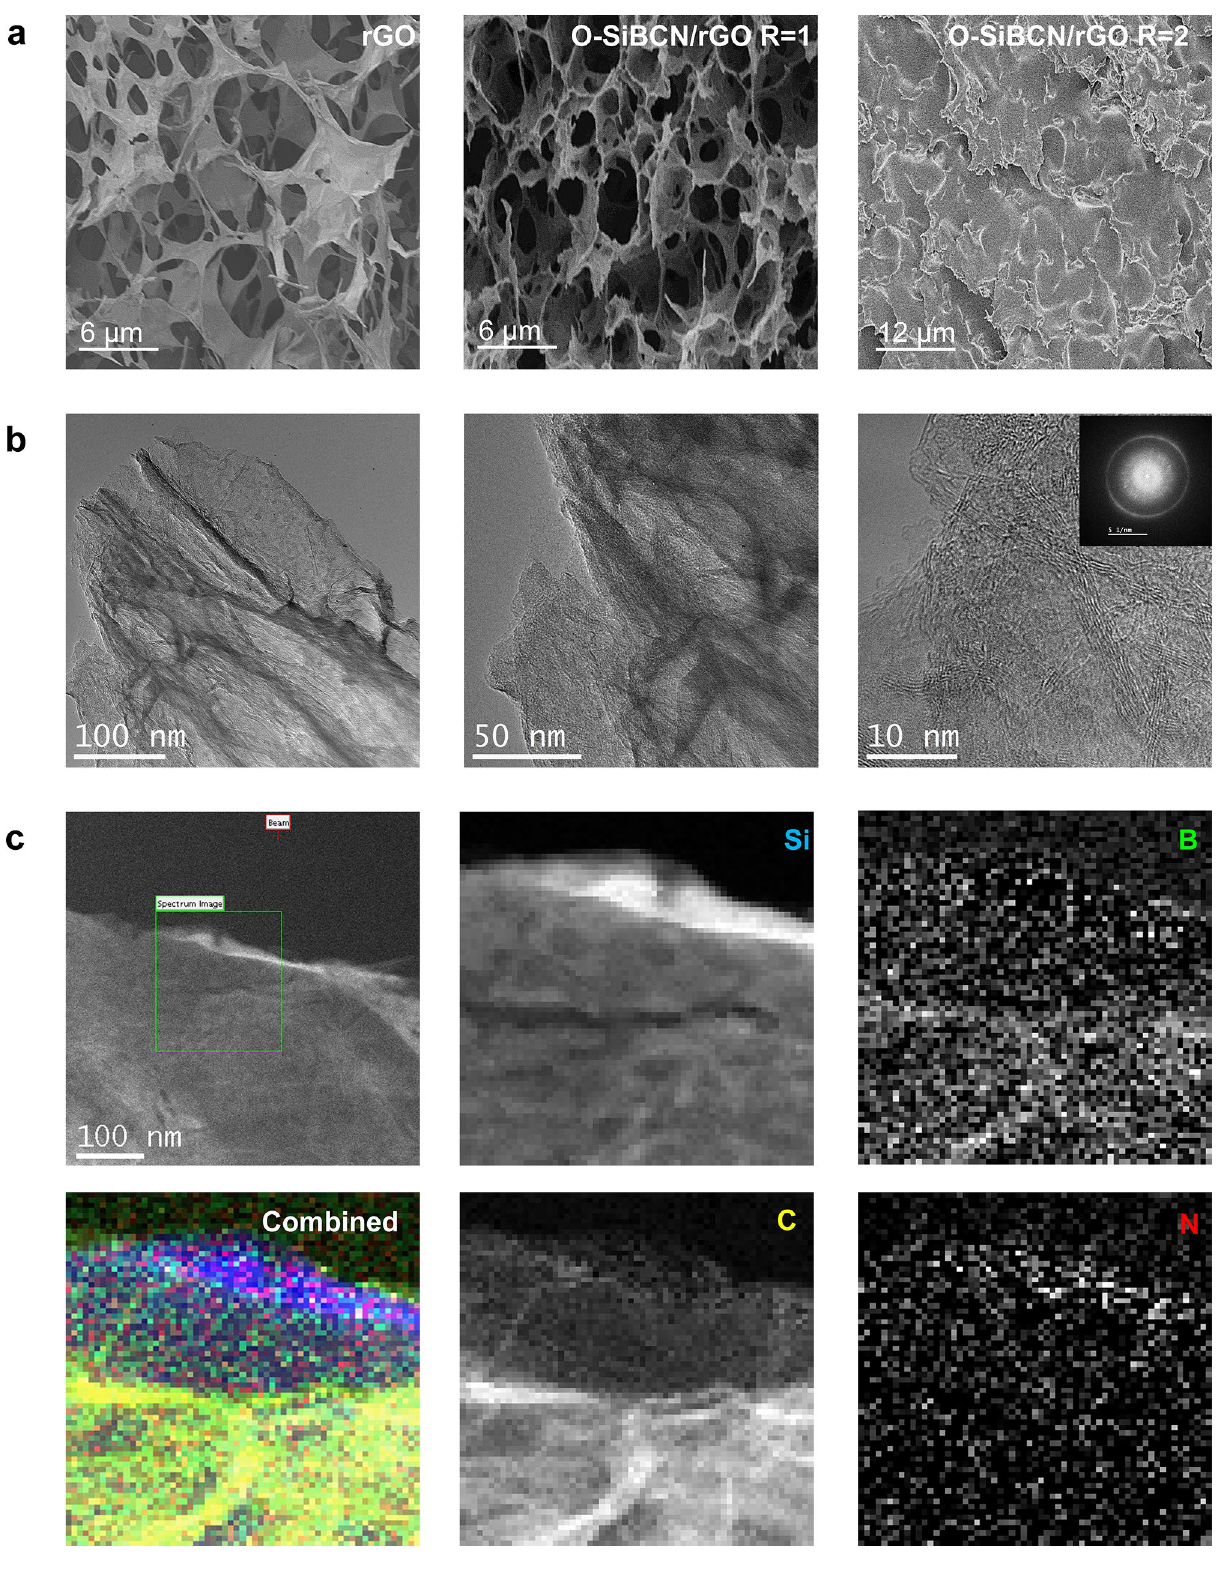
Figure 3. ( a ) High-magnification SEM images of rGO foam, O-SiBCN/rGO and O-SiBCN/rGO composite with a PDC/rGO ratio of 1 and 2 respectively. ( b ) TEM images of O-SiBCN/rGO (R O-SiBCN/rGO = 1). ( c ) TEM images and the corresponding EELS chemical maps of O-SiBCN/rGO (R O-SiBCN/rGO = 1) (Silicon (blue), Boron (green), Carbon (yellow), Nitrogen